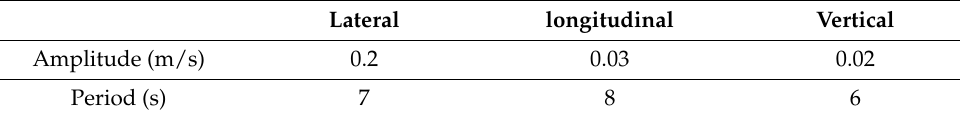
Table 3. Linear velocity parameter settings.